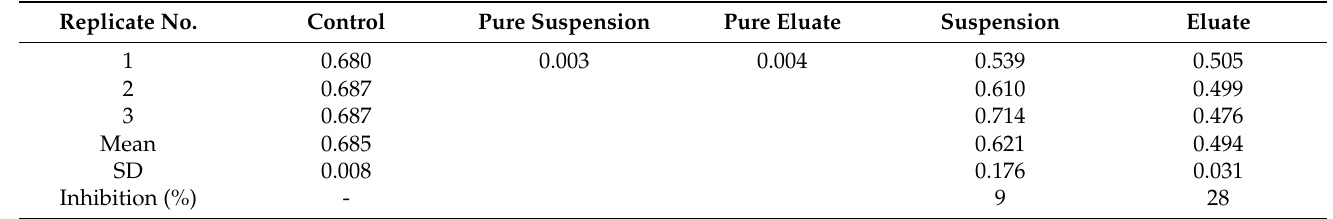
Table 3. The absorbances of MTT viability assay after 7 days of exposure. Pure suspension = suspension without microorganism, pure eluate = eluate without microorganisms. The data are expressed as mean values of absorbances with their standard deviations (SDs) and as an inhibition in